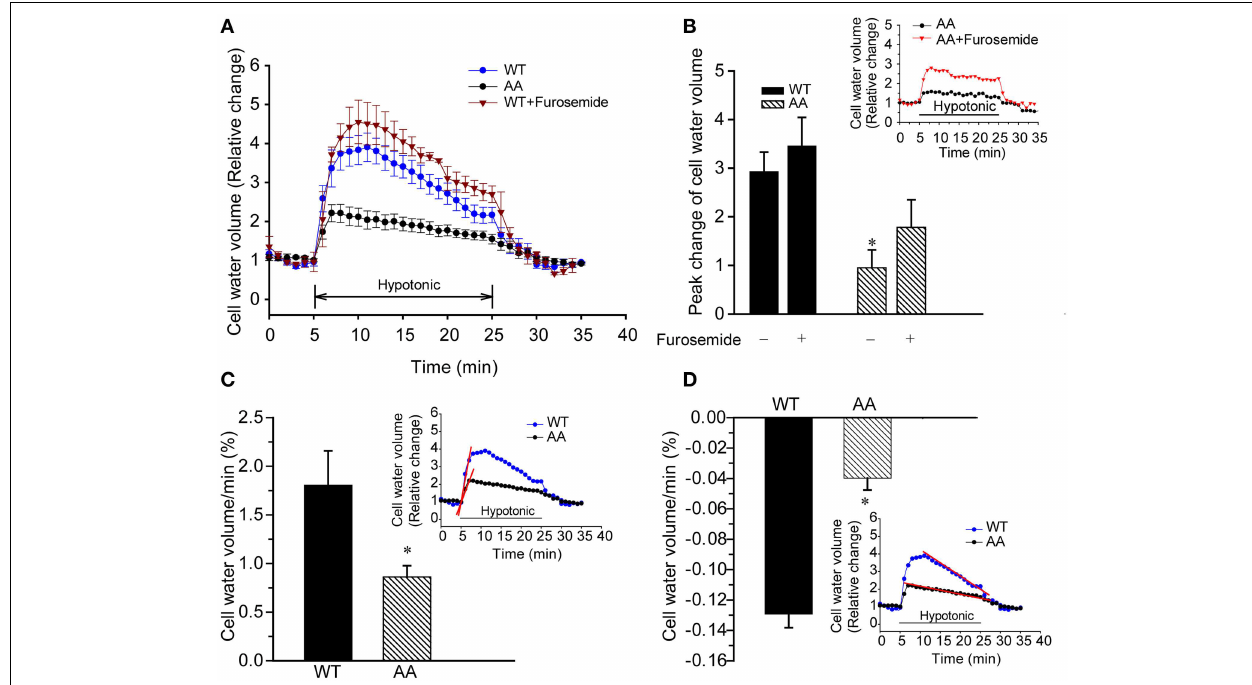
KCC3 AA cells in presence or absence of furosemide. Data are means ± SE. n = 5 , * P < 0 . 05 vs. WT control. P = 0 .1 WT + furosemide vs. AA + furosemide. (C) Rate of cell volume change. Bar graphs represent the rate constants from the slopes (red line) calculated by fitting a linear regression to the cell water volume data (relative change) during the initial swelling response (5–6min, inset: slopes in red). * p < 0 . 05 vs. WT. (D) Regulatory volume decrease (RVD). Bar graphs represent the rate constants from the slopes (red line) calculated by fitting a linear regression to the cell volume relative change data during 10–24min of cell volume recovery (inset: slopes in red). Data are means ± SE. n = 5 experiments. * p < 0 . 05 vs.